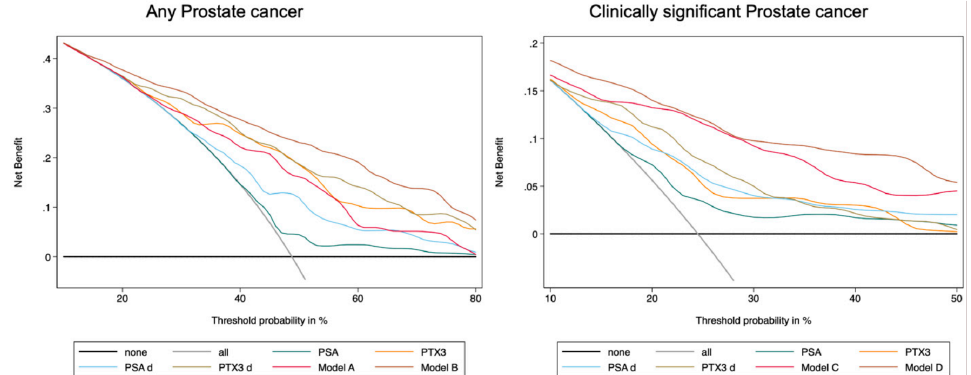
Figure 1. Decision curve analysis (DCA) comparing clinical utility of PTX3, PSA, PSA density, and PTX3 density for detecting any prostate cancer and csPCa. The DCA simulates two scenarios—one in which all patients would receive biopsy (all) and one in which none undergoes biopsy (none). Clinically useful models lie above these scenarios. PTX3 alone and models including PTX3 (Model B and Model D) showed a higher net benefit at each threshold probability and thus outperformed PSA alone and model including only standard variables in determining the need for a prostate biopsy.